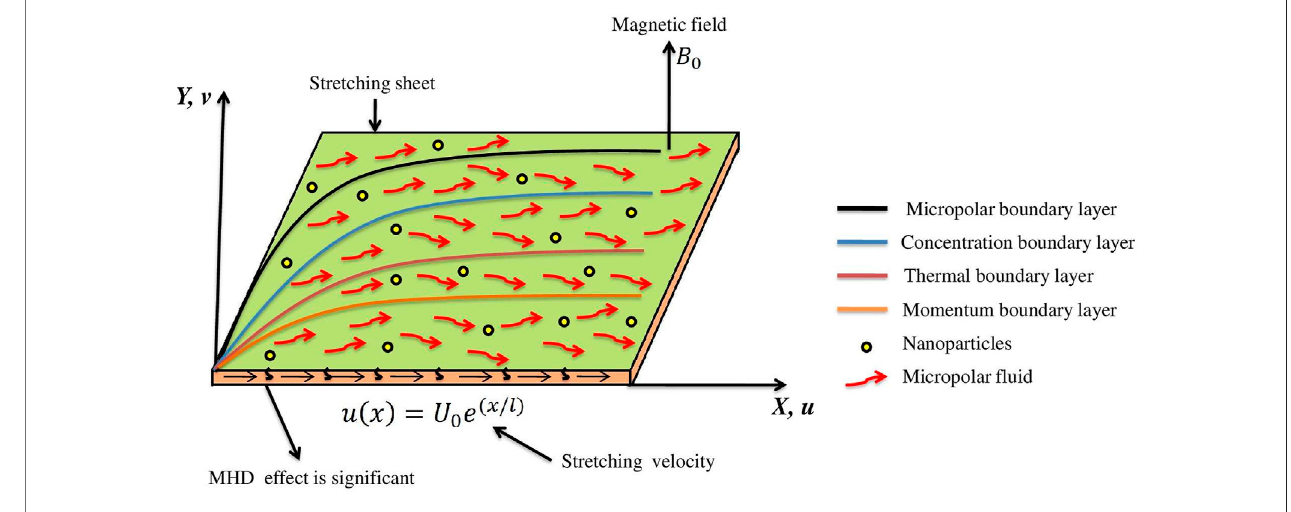
FIGURE 1 | Geometry of the fl ow.